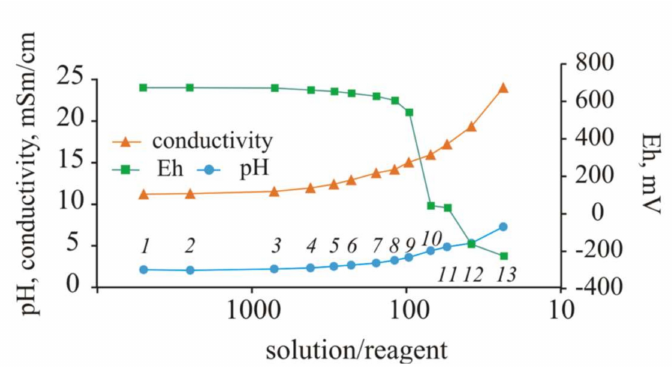
Figure 5. Changes in the physicochemical conditions and EC during the experiment with Na 2 S. S / R ratio decreased as follows: 1 —5000; 2 —2500; 3 —714; 4 —417; 5 —294; 6 —227; 7 —156; 8 —119; 9 —96; 10 —69; 11 —54; 12 —38; 13